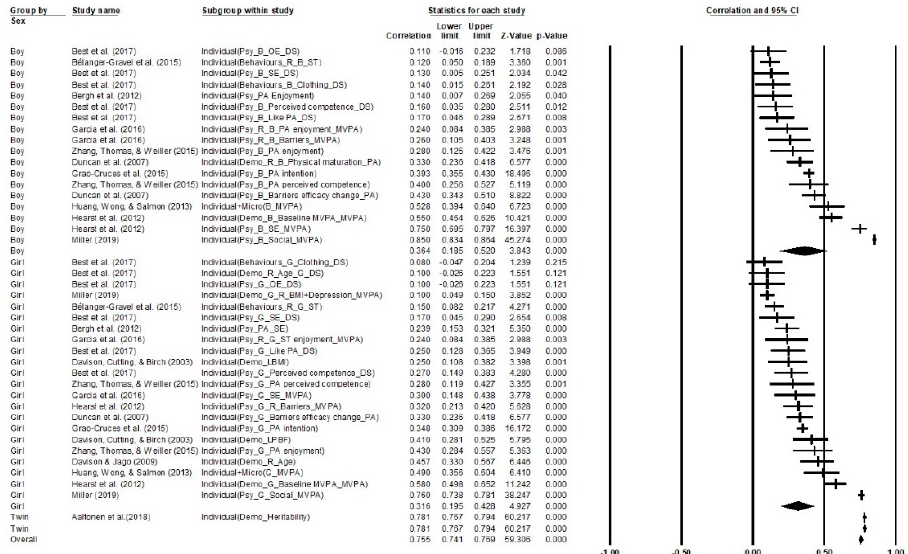
Figure 4. Correlations on individual factors in children and adolescents’ PA. Note. ASP = After school physical activity promotion; ATS = Active transport to school; B = Boy; CIM = Children independent mobility; DAP = During adolescent period; DS = Daily steps; R = Reversed correlation; EO = Environmental opportunities; ES = Extracurricular sport; G = Girl; OE = Outcome experiences; PD = Parent daughter; SE = Self-efficiency; SPE = School physical education promotion; WD = Weekend; WY = Weekday.